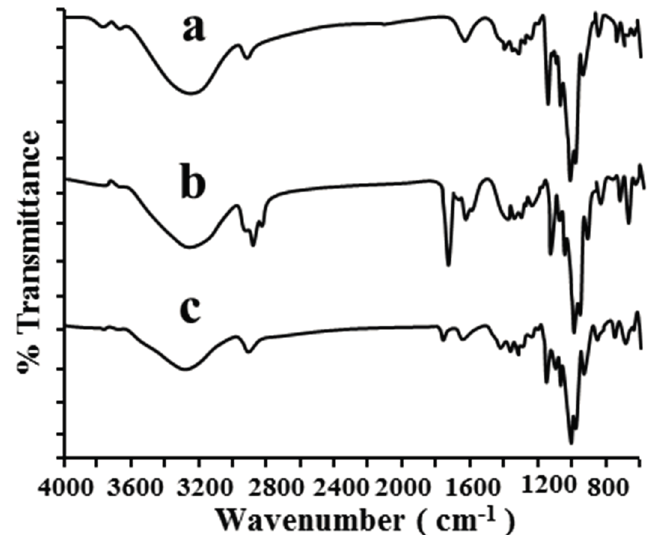
Figure 3. FT-IR spectra of β -CD ( a ); the physical mixture ( b ) and the inclusion complex ( c